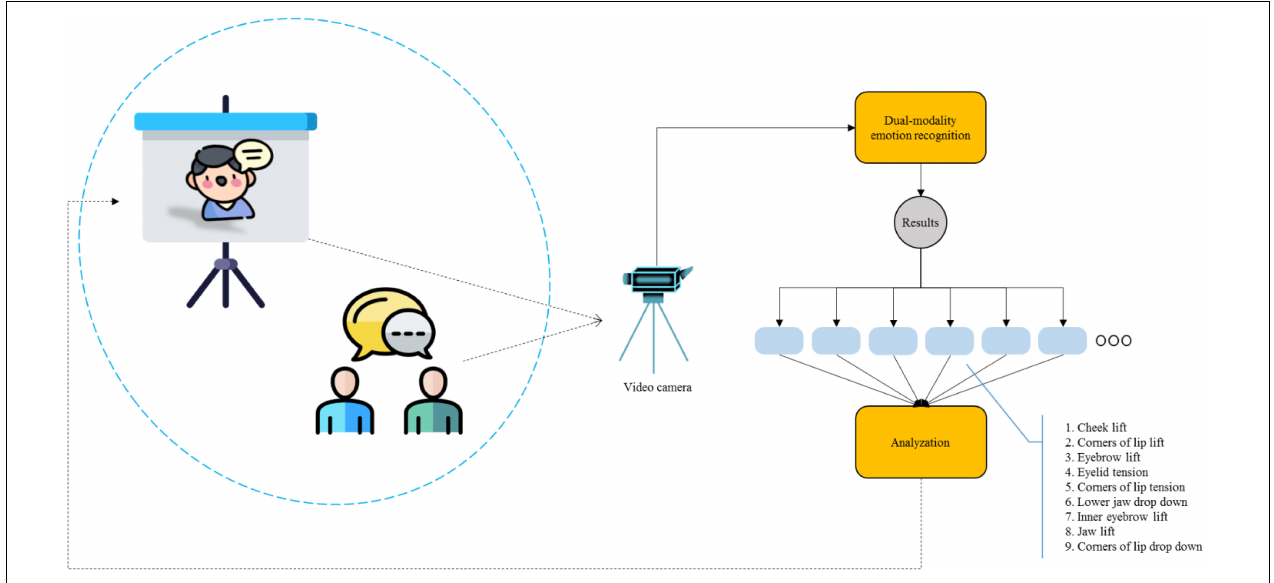
FIGURE 2 | The overall framework of interactive English-speaking